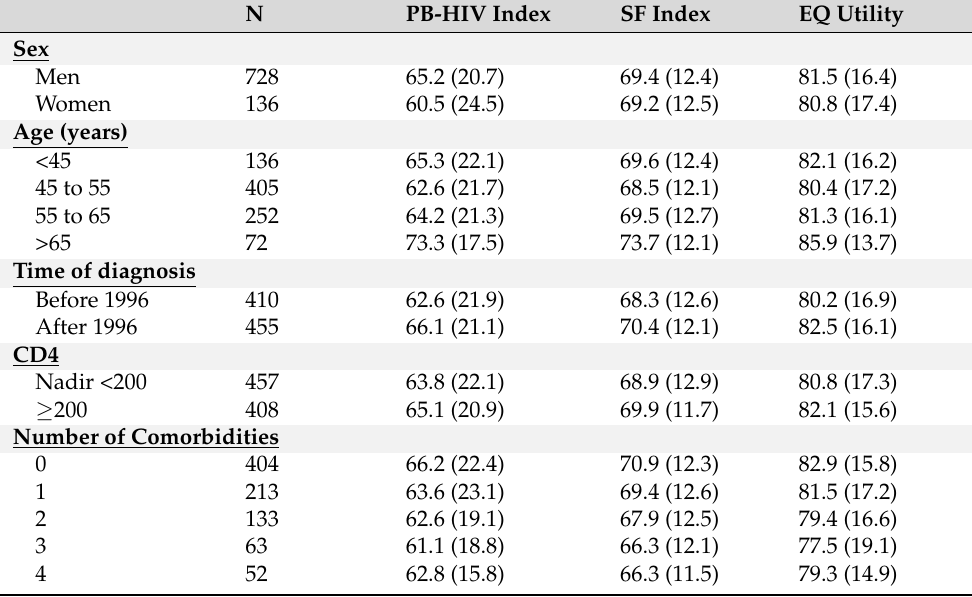
Table 6. Performance of PB-HIV Index total score and other generic measures across sex, time of diagnosis, disease severity, and